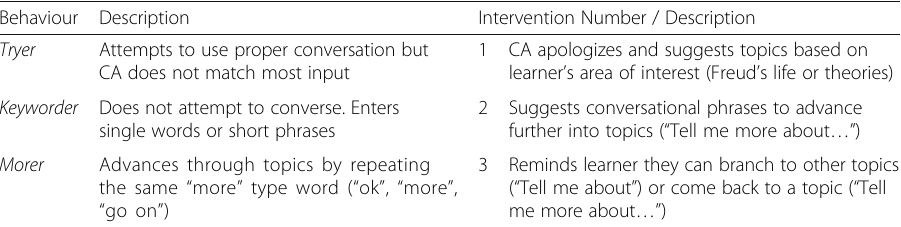
Table 2 Behaviour types and interventions Behaviour Description Intervention Number / Description